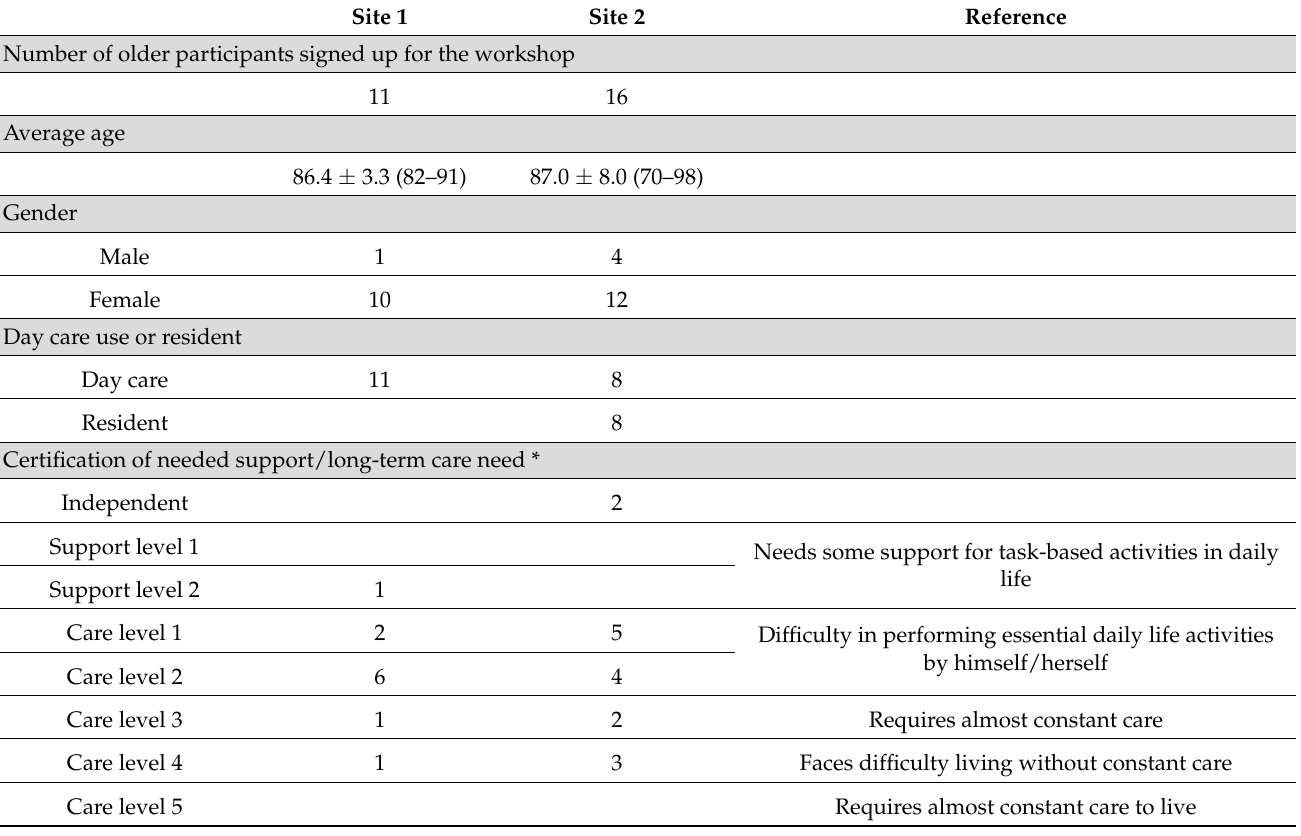
Table 2. Characteristics of the older